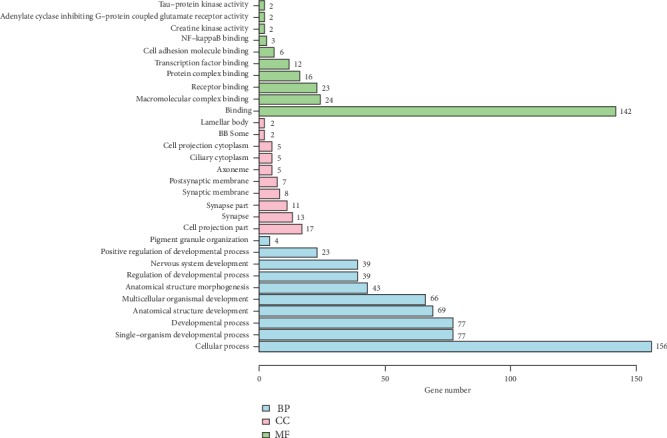
GO categories assigned to all 6867 integration genes. Note: the y-axis represents the count of genes. The genes were categorized according to the annotation of GO, and the number of each category is displayed based on biological process (BP), cellular components (CC), and molecular functions (MF).